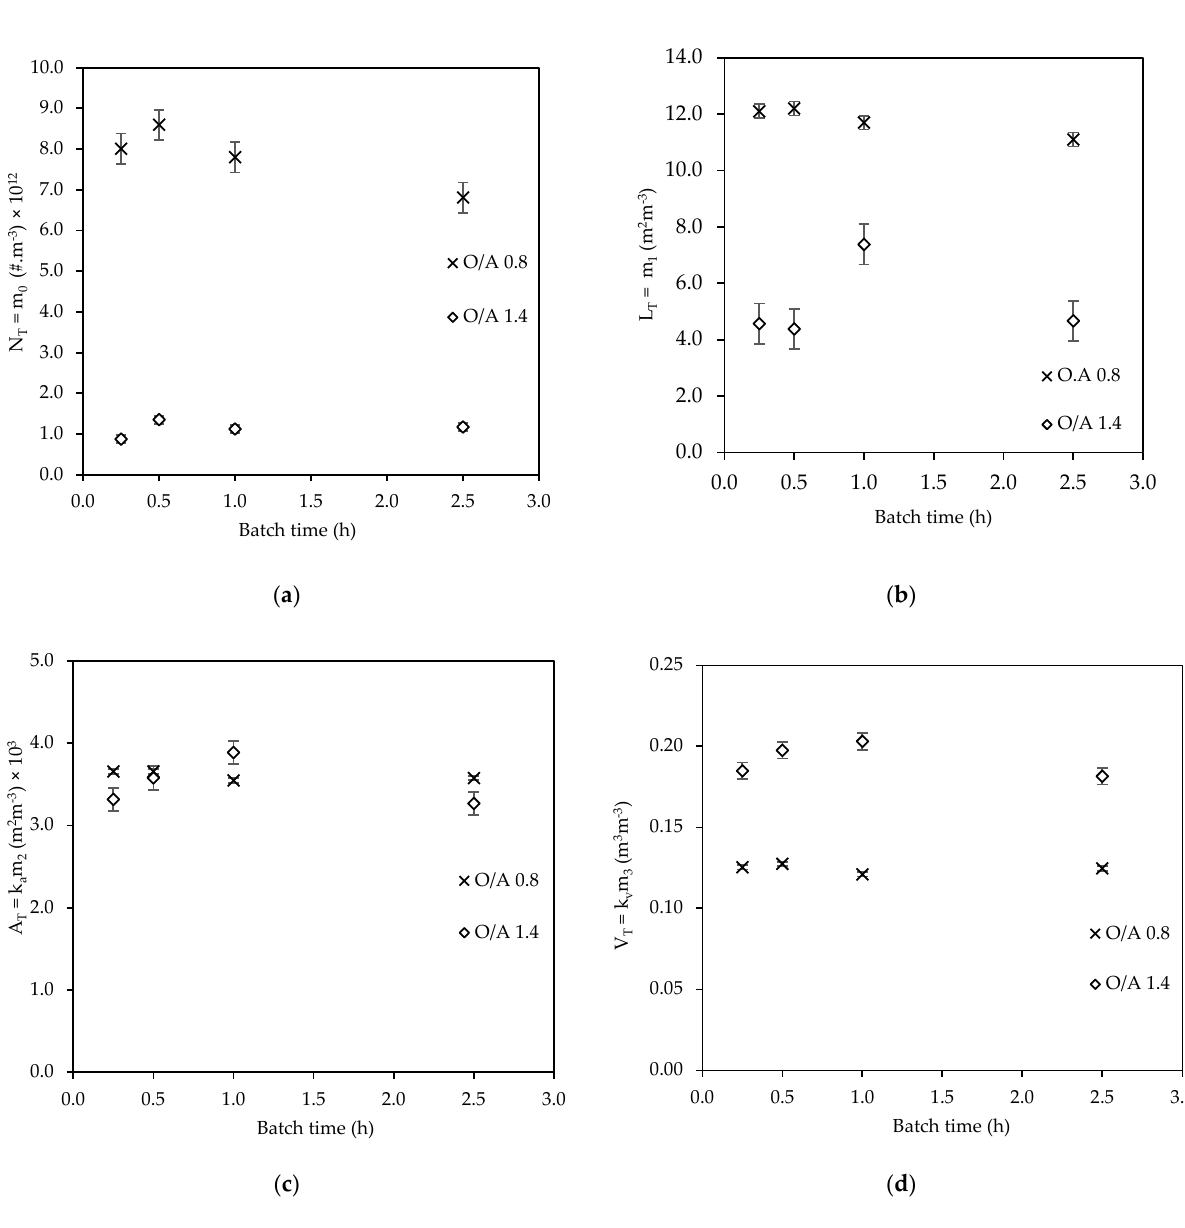
Figure 7. Evolution of moments at the O/A ratio of 0.8 and 1.4 ( a ) total number (N T ); ( b ) total length (L T ); ( c ) total surface area (A T ); and ( d ) total volume (V T ). As noted by Palosaari et al. [34], the degree of supersaturation is the main parameter that determines the rate of nucleation, growth, and agglomeration. Therefore, it deter- mines the size, morphology, and purity of the crystals. Since the supersaturation at the O/A ratio of 1.4 was higher than at 0.8, a faster nucleation rate was expected at the O/A ratio of 1.4. However, the results show that fewer particles of more volume were obtained at the O/A ratio of 1.4 than at 0.8. This suggests that the smaller particles produced at the O/A of 1.4 possibly agglomerated resulting in larger mean particle sizes, hence the shift of the PSD in Figure 4 to the right for this amount of ethanol. Yu et al. [16] in their study, produced fine particles (<2 µm) with defined morphology. The fine particles were at- tributed to high supersaturation at higher O/A ratios, and these particles agglomerated.